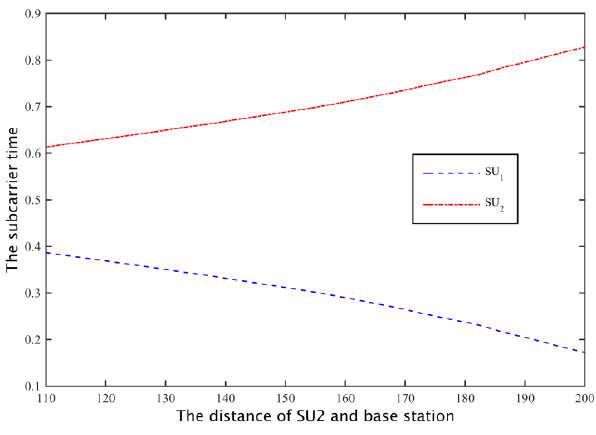
Figure 18. The optimal time assignments of secondary users.